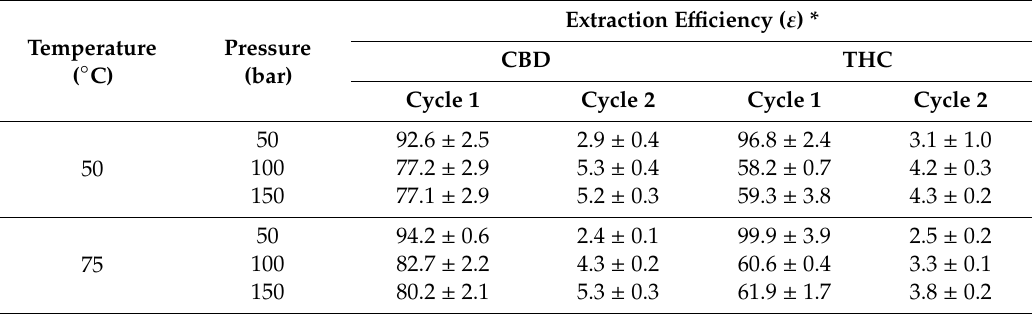
Table 4. Extraction efficiency of the PLE experiments performed in the speed extractor (Section 2.4, Table 1).